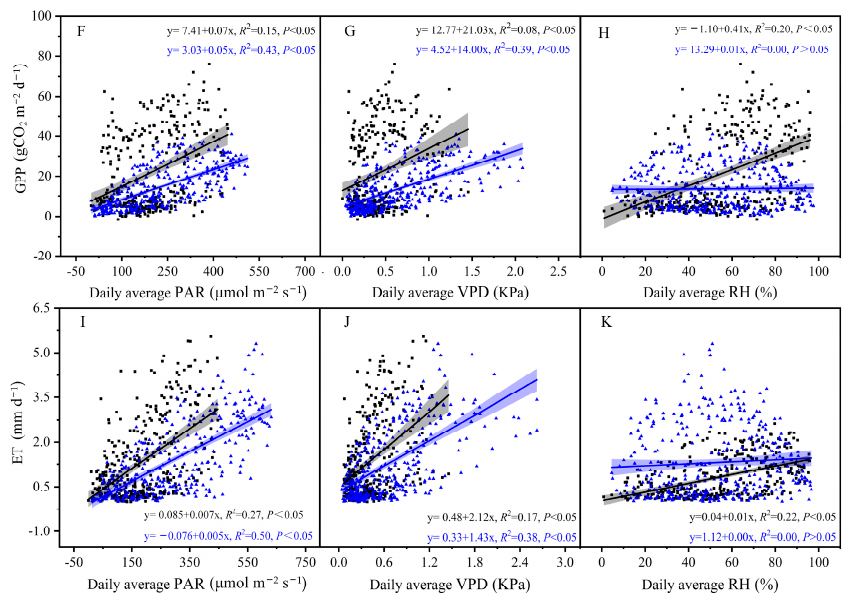
Figure 4. The regression relationship between the daily CO 2 /H 2 O fluxes (NEP (negative NEE), RECO, GPP, and ET) and daily environmental factors (photosynthetic active radiation ( A , F , I ), vapor pressure deficit ( B , D , G , J ), and air relative humidity ( C , E , H , K ) in two forest ecosystems. ( A – H ) indicate different small panels.